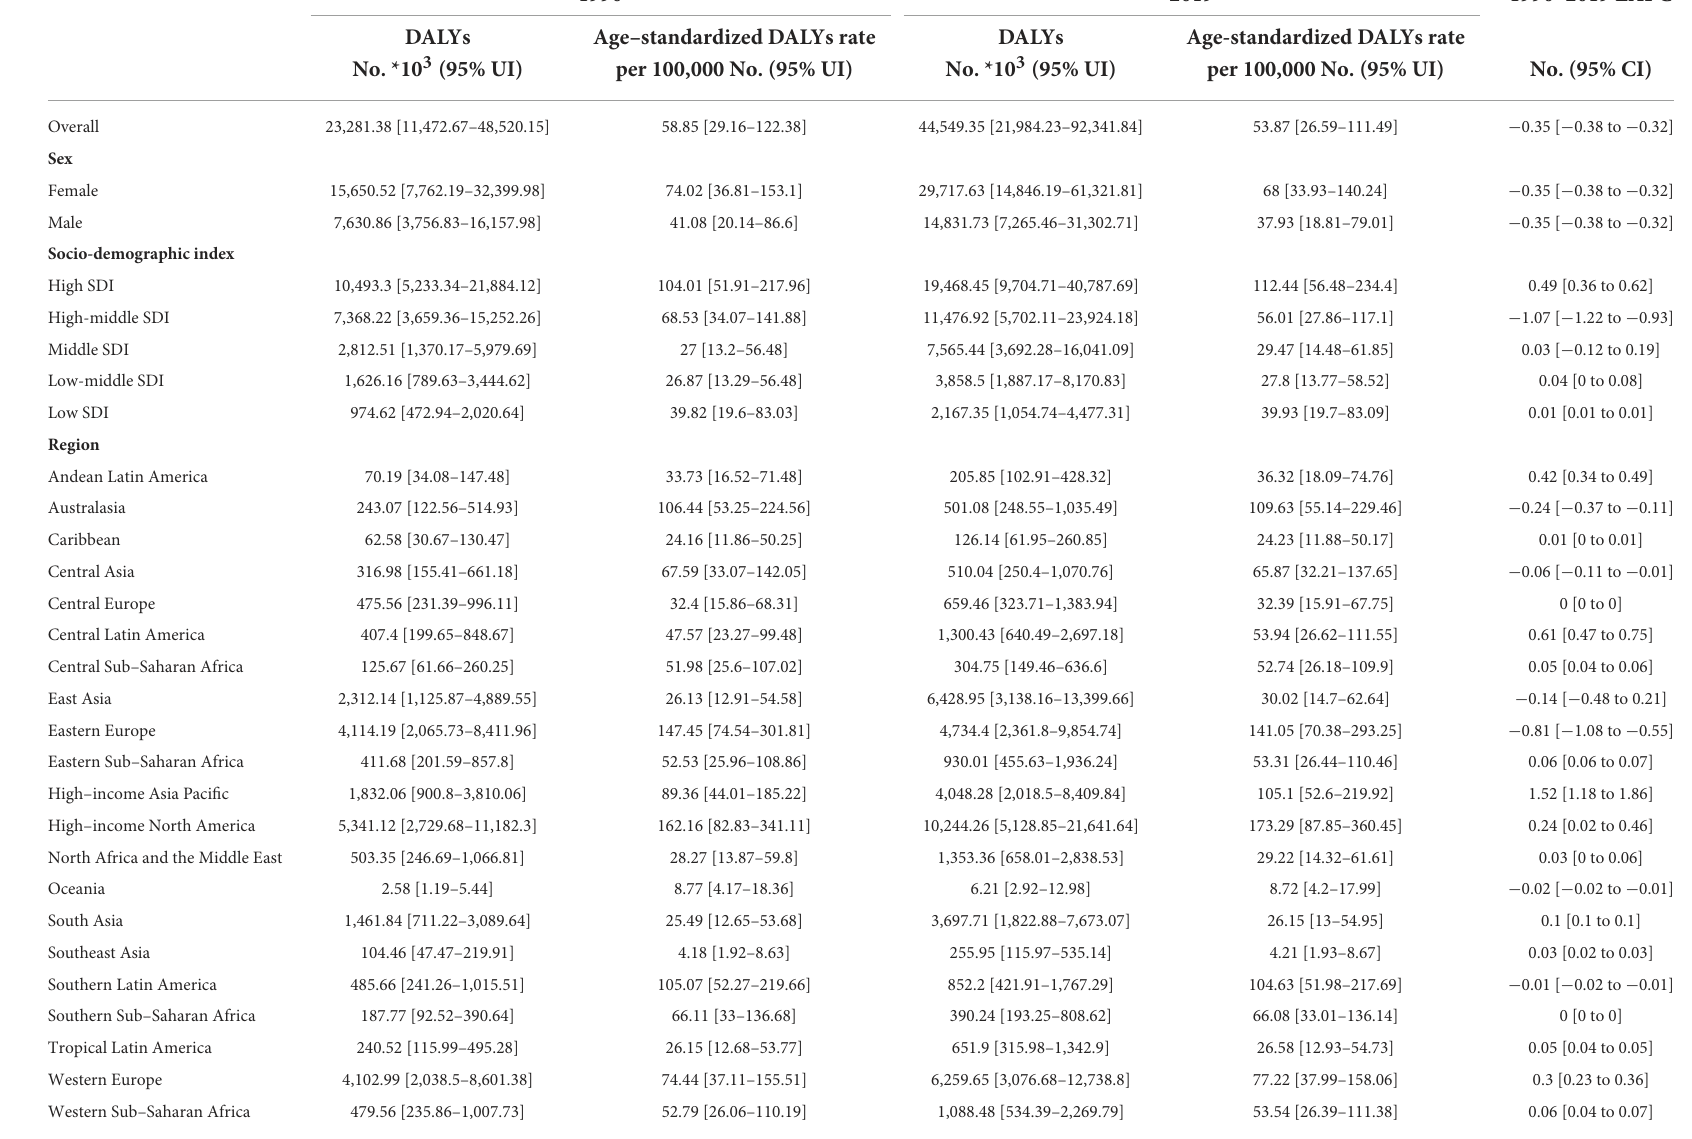
TABLE 2 DALYs and age-standardized DALY rate in 1990 and 2019 and its up-to-date trends from 1990 to